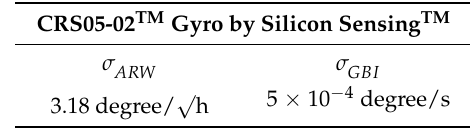
and gyro bias instability σ ARW